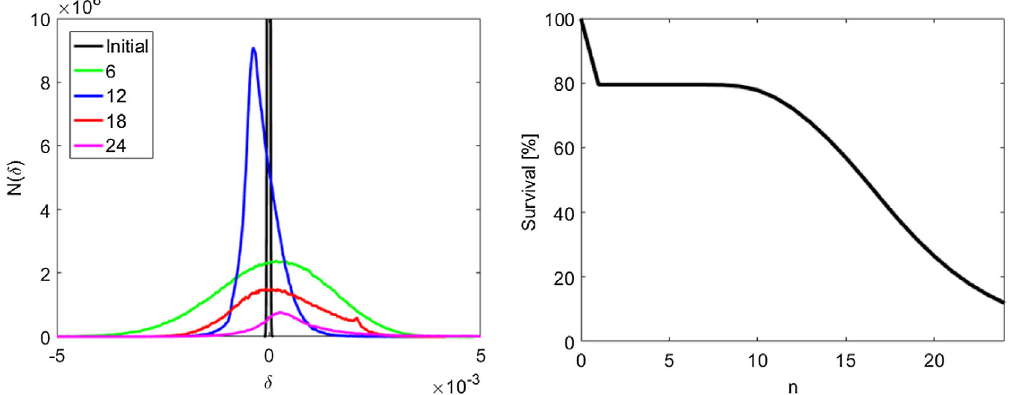
FIG. 16. Energy spectra and particle survival rate for a short low energy